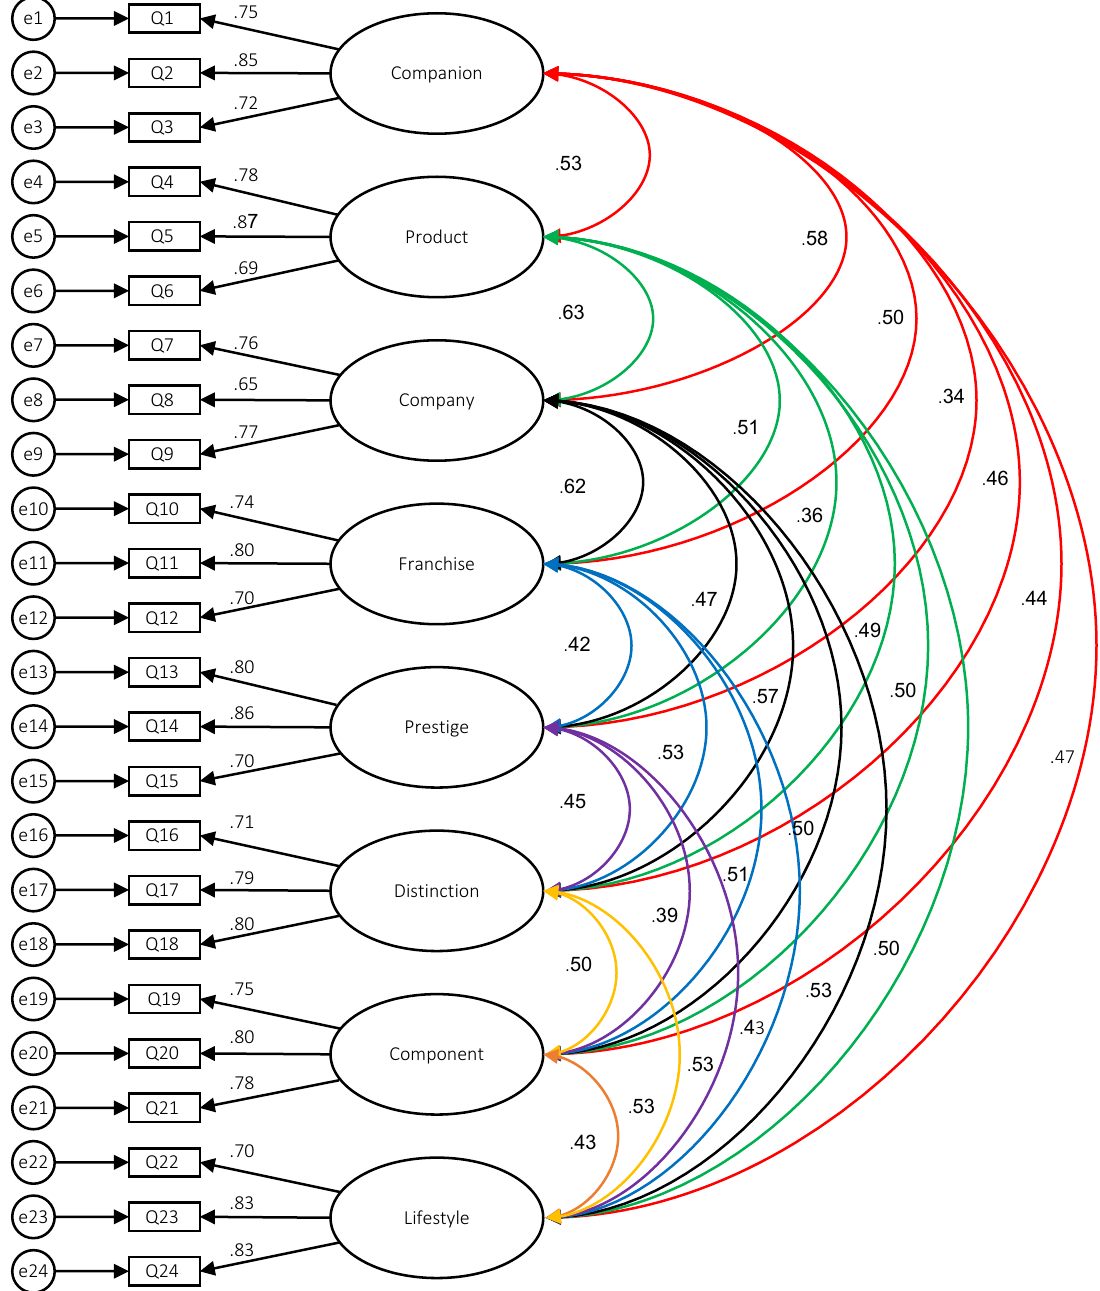
Figure 1. Confirmatory factor analysis for testing the first-order